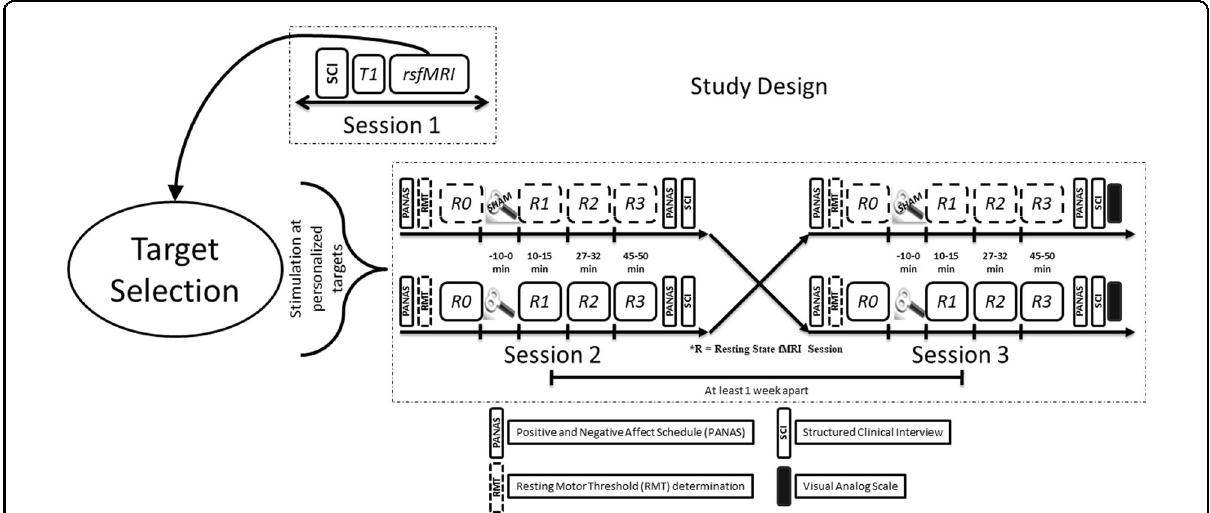
Fig. 1 A schematic representation of the study design. In session 1, we obtained the informed consent and collected the information (see main text for details) from Structured Clinical Interviews (SCI). After this we acquired a structural (T1-weighted) and functional (rsfMRI) images. During rsfMRI, the subjects were instructed to fi xate at a “ + ” and mind wander, while their open eyes were monitored by eye tracking. Personalized targets were found using each subject ’ s rsfMRI as has been described elsewhere 19 . Using online neuronavigation, we delivered real or sham iTBS, in a counterbalanced and pseudo-randomized fashion, at 80% of resting motor threshold. Baseline and three post-iTBS rsfMRI scans were acquired. The subjects also completed the Positive and Negative Affect Schedule (PANAS) both before and after the sessions, and a visual analog scale (VAS) for perceived effects of iTBS on mental state and scalp sensation at the end of the